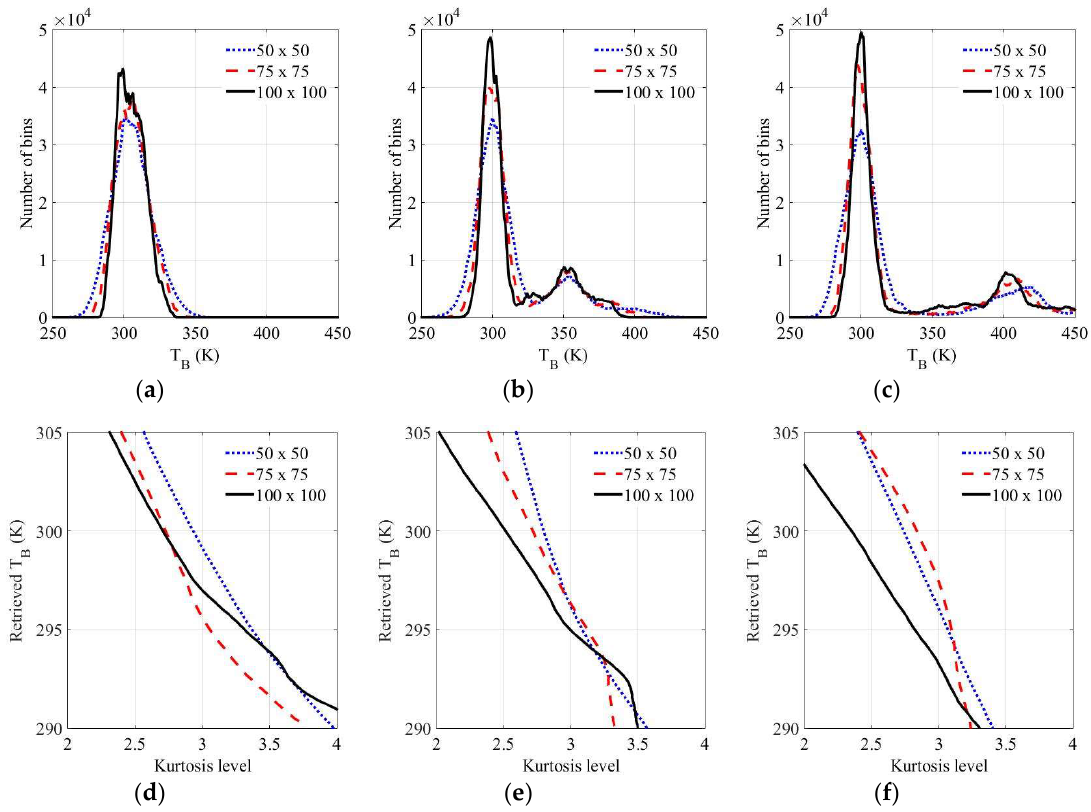
Figure 10. Processing results in Step 2: ( a – c ) distribution from the bins of the mean spectrogram eliminated by RFI-flagged bins in the skewness spectrogram when the RFI levels are 10, 50, and 100 K, respectively; ( d – f ) retrieved brightness temperature versus the kurtosis level when the RFI levels are 10, 50, and 100 K, respectively.